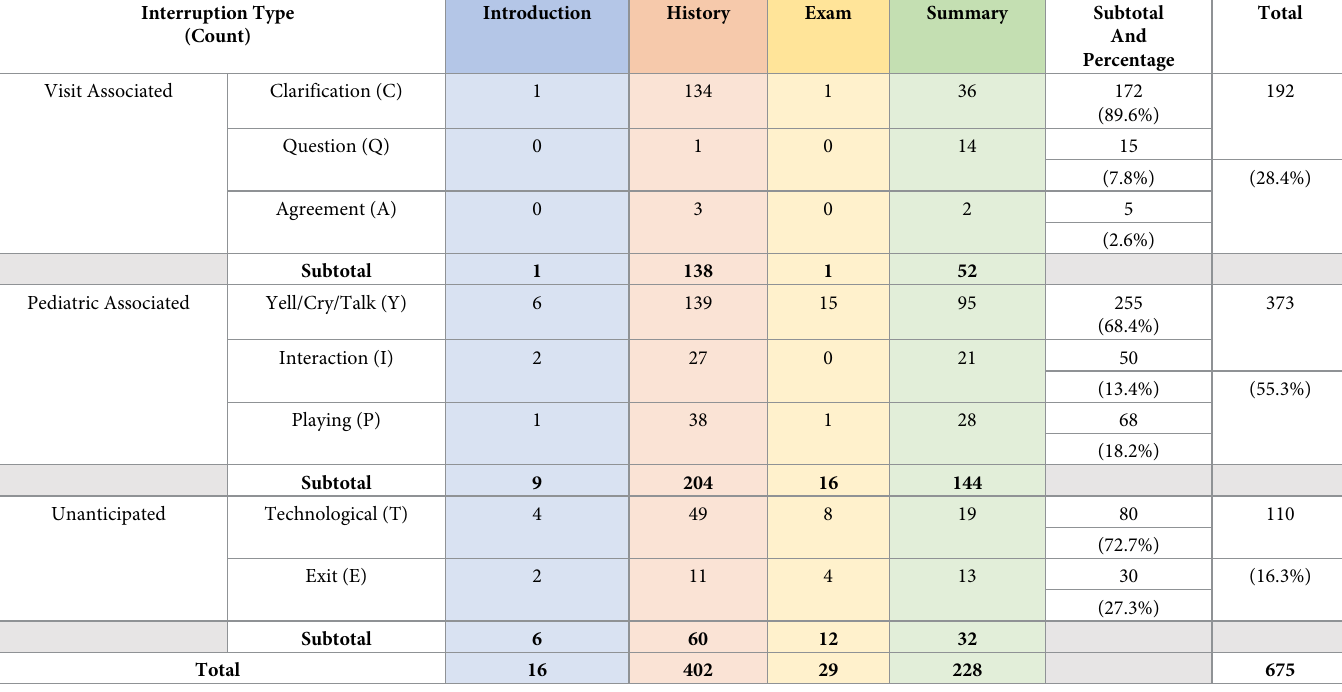
Table 2. Clinic visit distribution of interruption